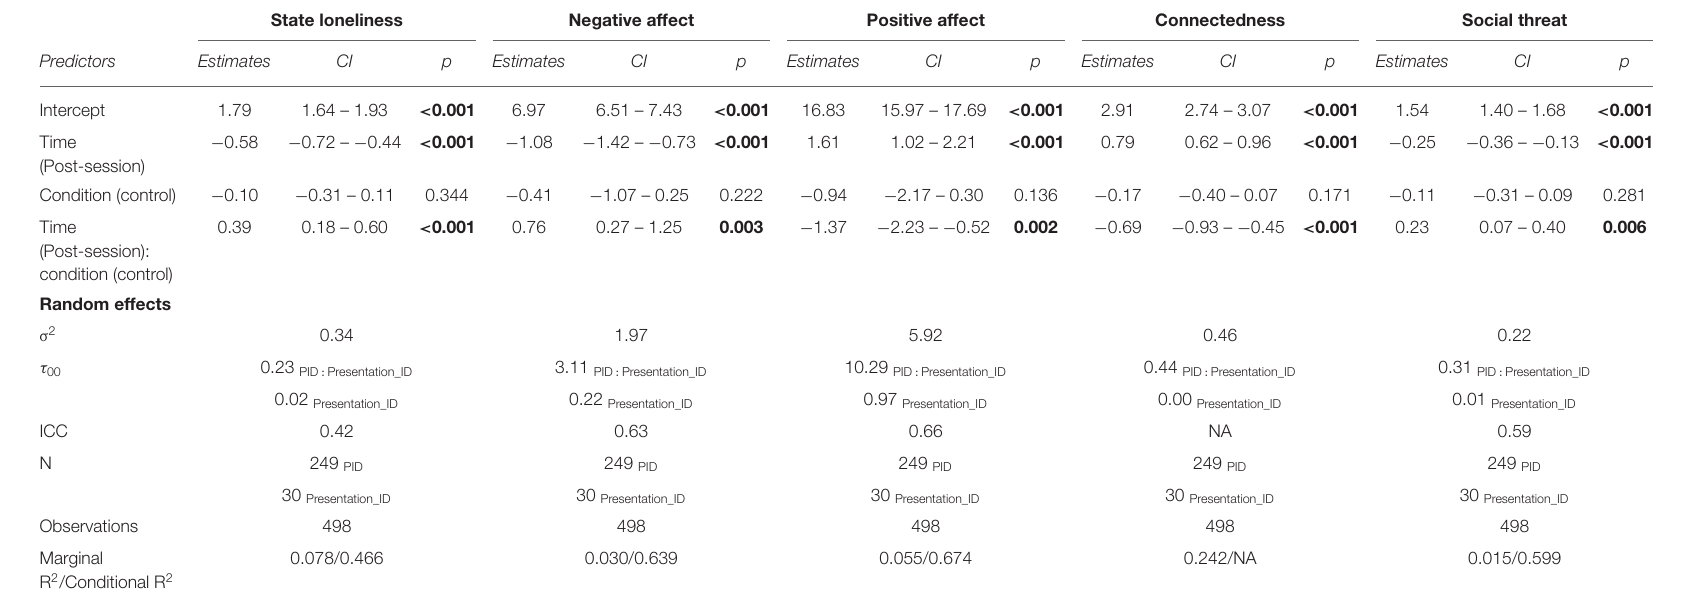
TABLE 2 | Results of the 5 short-term change hypotheses. State loneliness, negative affect, positive affect, connectedness, and social threat all changed in the predicted directions to greater extents in the experimental condition than in the control condition. State loneliness Negative affect Positive affect Connectedness Social threat